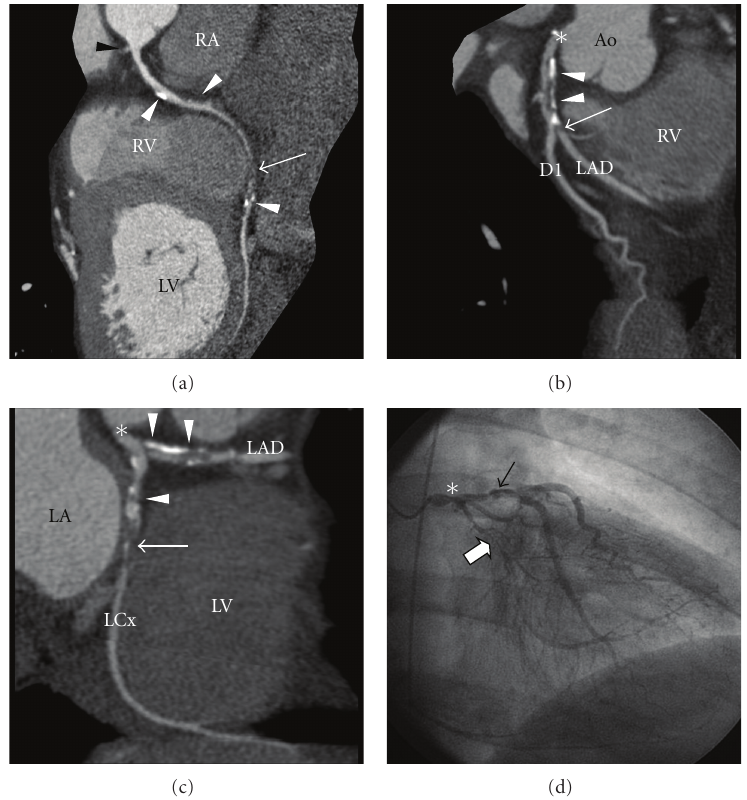
Figure 3: 61-year-old male with aggressive large B-cell lymphoma developed chest pain after the first cycle of chemotherapy. Electrocardiogram and cardiac enzyme measurements are consistent with NSTEMI. Echocardiography demonstrated a decrease in left ventricular ejection fraction from a normal baseline to 40%. Due to postchemotherapy thrombocytopenia and leucopenia, an invasive coronary angiogram could not be obtained. Based on the coronary CT angiogram results, further chemotherapy was placed on hold. Invasive coronary angiography was performed after recovery of blood counts, followed by coronary artery bypass grafting. Two weeks later, the patient restarted chemotherapy. (a) Curved reformat view of the right coronary artery shows scattered calcific and noncalcified atherosclerotic plaque (white arrowheads) with possible occlusion (arrow) near the junction of the mid and distal segments. The conus branch origin (black arrowhead) is identified. (b) Curved reformat view of the left anterior descending artery (LAD) shows calcific and noncalcified atherosclerotic plaque (white arrowheads) in the proximal LAD, with focal near occlusion (arrow) of the LAD at the origin of the first diagonal (D1). Also noted is a mixed ostial left main artery plaque (asterisk). (c) Curved reformat view of the circumflex coronary artery (LCx) and proximal LAD showscalcific and noncalcified atherosclerotic plaque (arrowheads) in the proximal segments of both vessels. The LCx appears occluded at the junction of the proximal and middle segments (arrow). The ostial left main artery plaque in this projection appears noncalcified and significantly stenotic (asterisk). LA = left atrium. LV = left ventricle. RA = right atrium. RV = right ventricle. Ao = Aortic root. (d) Invasive angiogram demonstrating same findings with good correlation. The left main coronary is significantly stenosed (asterisk). The left anterior descending artery shows multiple high grade stenoses (thin arrow) and the left circumflex artery is occluded (thick